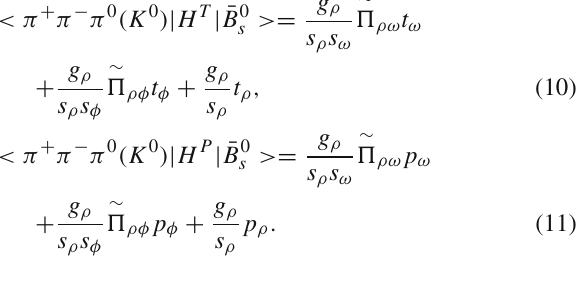
Fig. 1 The diagrams of ¯ B 0 s → π + π − π 0 ( K 0 ) decay